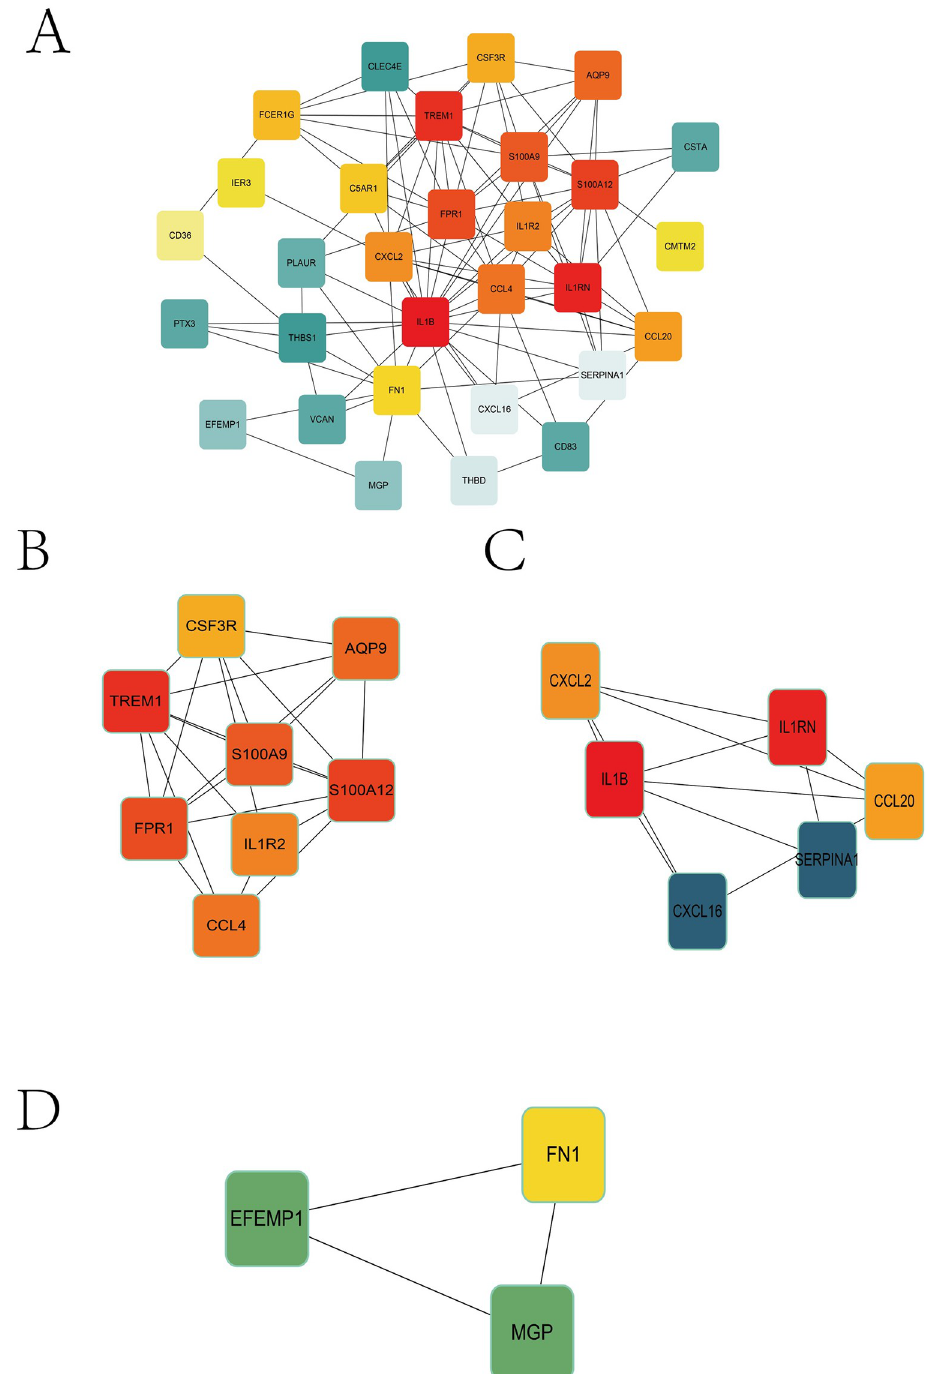
Fig 3. PPI network. MCODE uncovered a DEG PPI network with three cluster components. a Protein-protein interaction network generated by DEGs. Protein-protein associations are represented by the nodes and edges of the graph. Red diamonds express upregulated genes, whereas green and blue hexagons represent downregulated genes. MCODE was able to extract three cluster modules. With the most points, Cluster 1 (b) was the winner, followed by Cluster 2 (c) and Cluster 3.